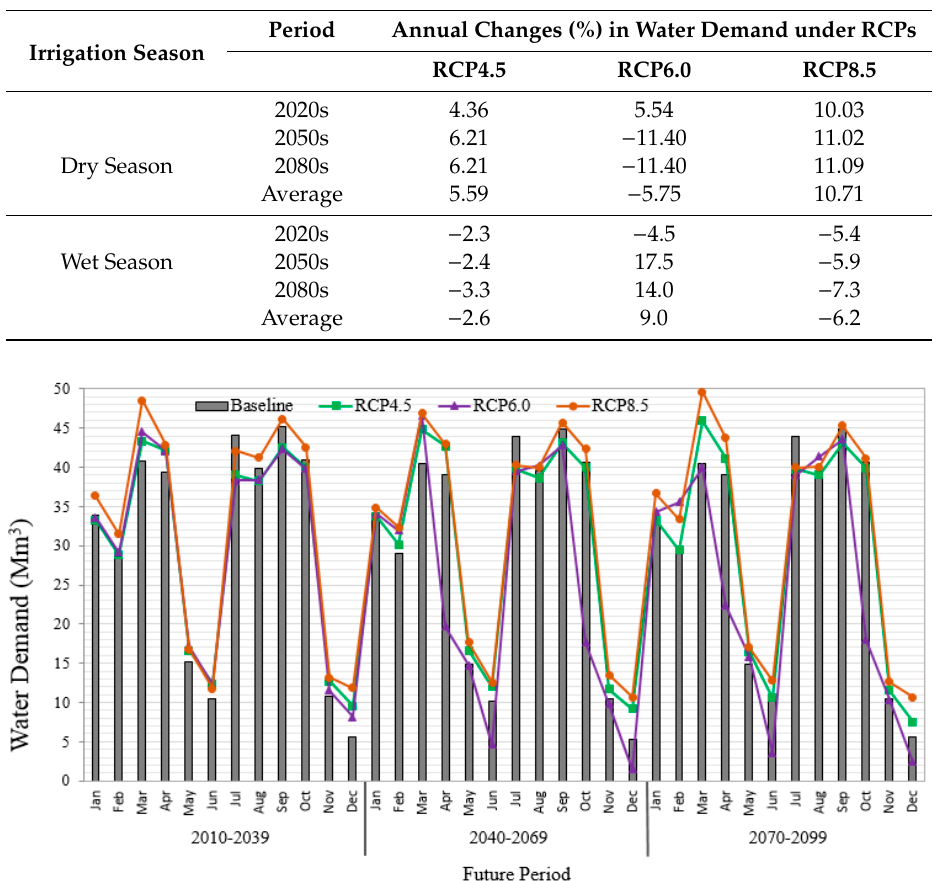
Figure 9. Projected mean monthly water demand from multiple models for three RCP scenarios (RCPs 4.5, 6.0, and 8.5) for three future periods of 2010–2039, 2040–2069, and 2070–2099 relative to the baseline period of 1976–2005.